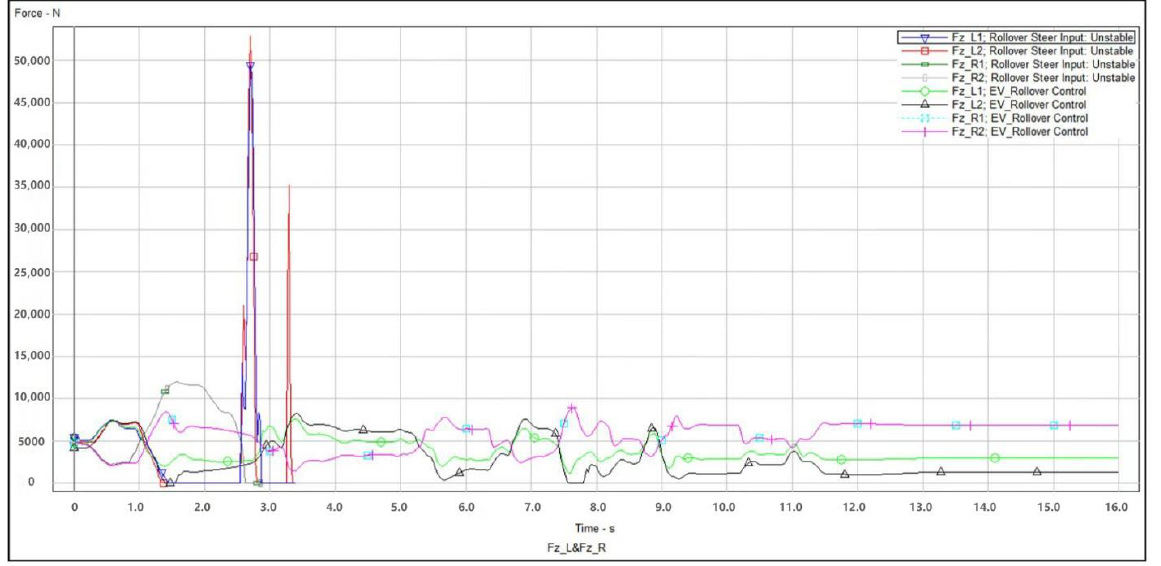
Figure 13. Roll rate comparison curve for double lane-change test.